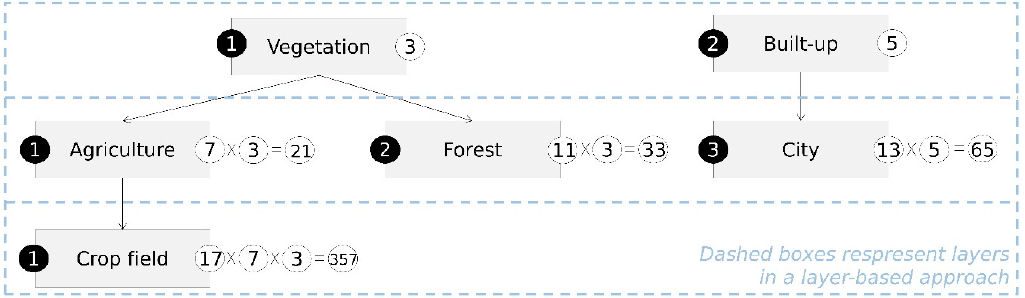
Figure 2. Example hierarchy comparing the layer ‐ based approach and the prime number encoding.